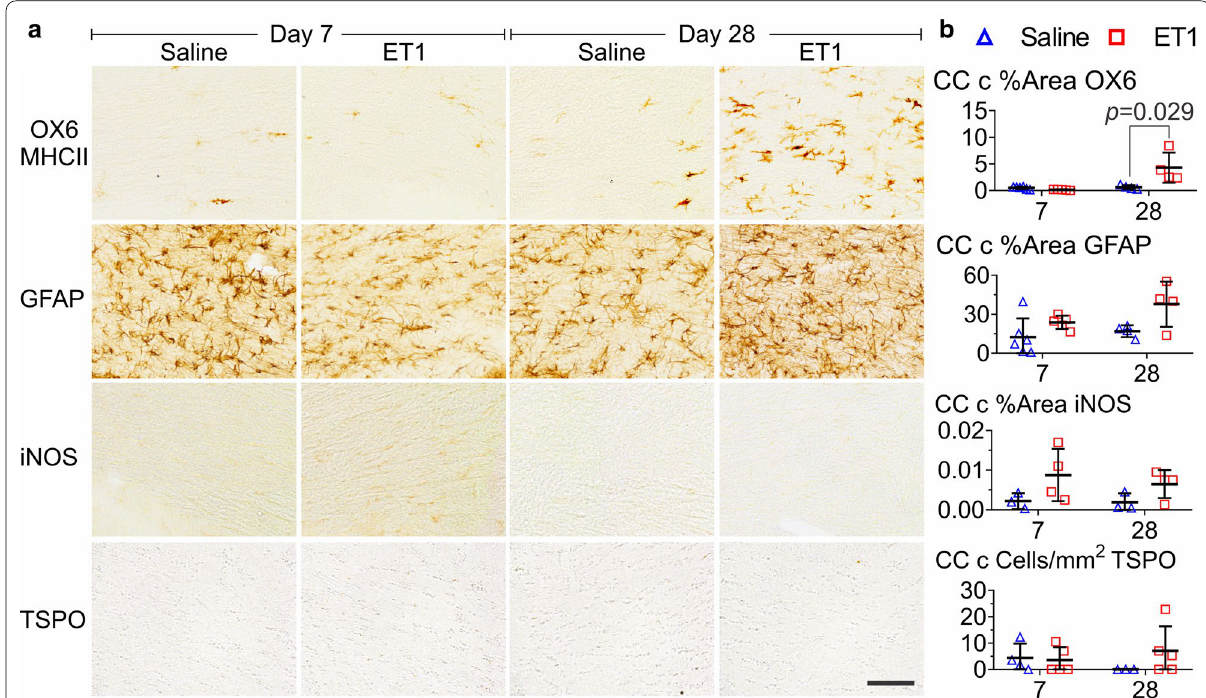
Fig. 5 WM immunohistochemistry in the contralateral corpus callosum (CC c) showing that at 28 days post‑stroke, ET1 rats only showed an elevation of OX6 (MHCII); not TSPO, iNOS, and GFAP. a Representative images and b quantification of cell count for TSPO and % area coverage for other markers. Bar indicates 100 µm. Error =